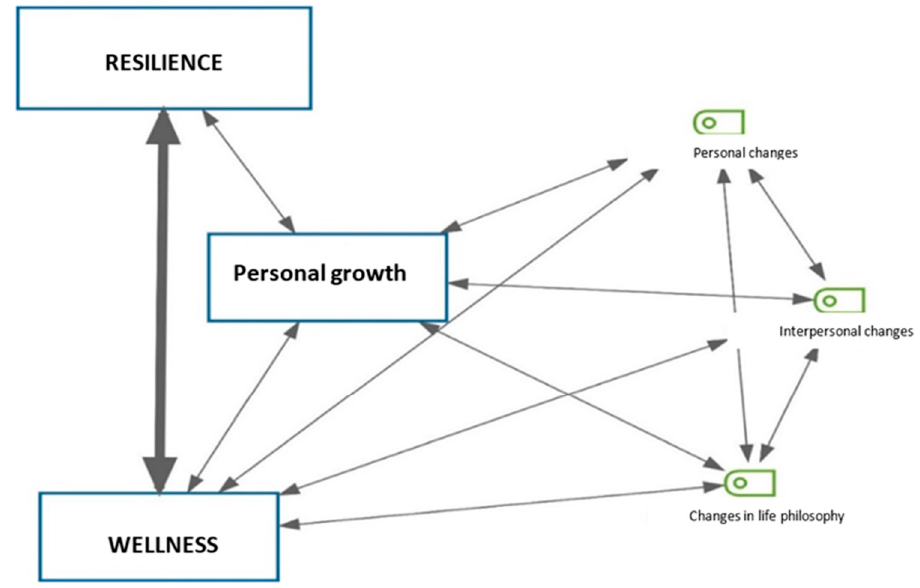
Figure 1. Map of Figure 1. Map of categories.